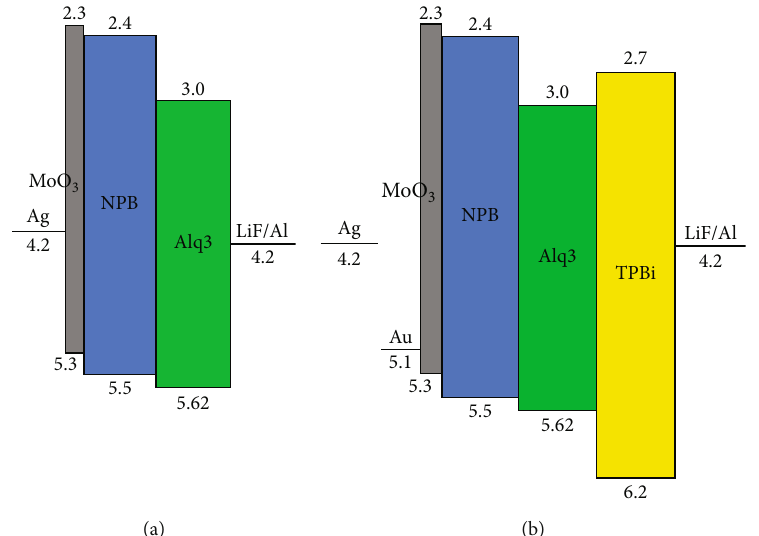
Figure 6: (a) TE-OLED energy level diagram with MoO anode side and TPBi on the cathode side.